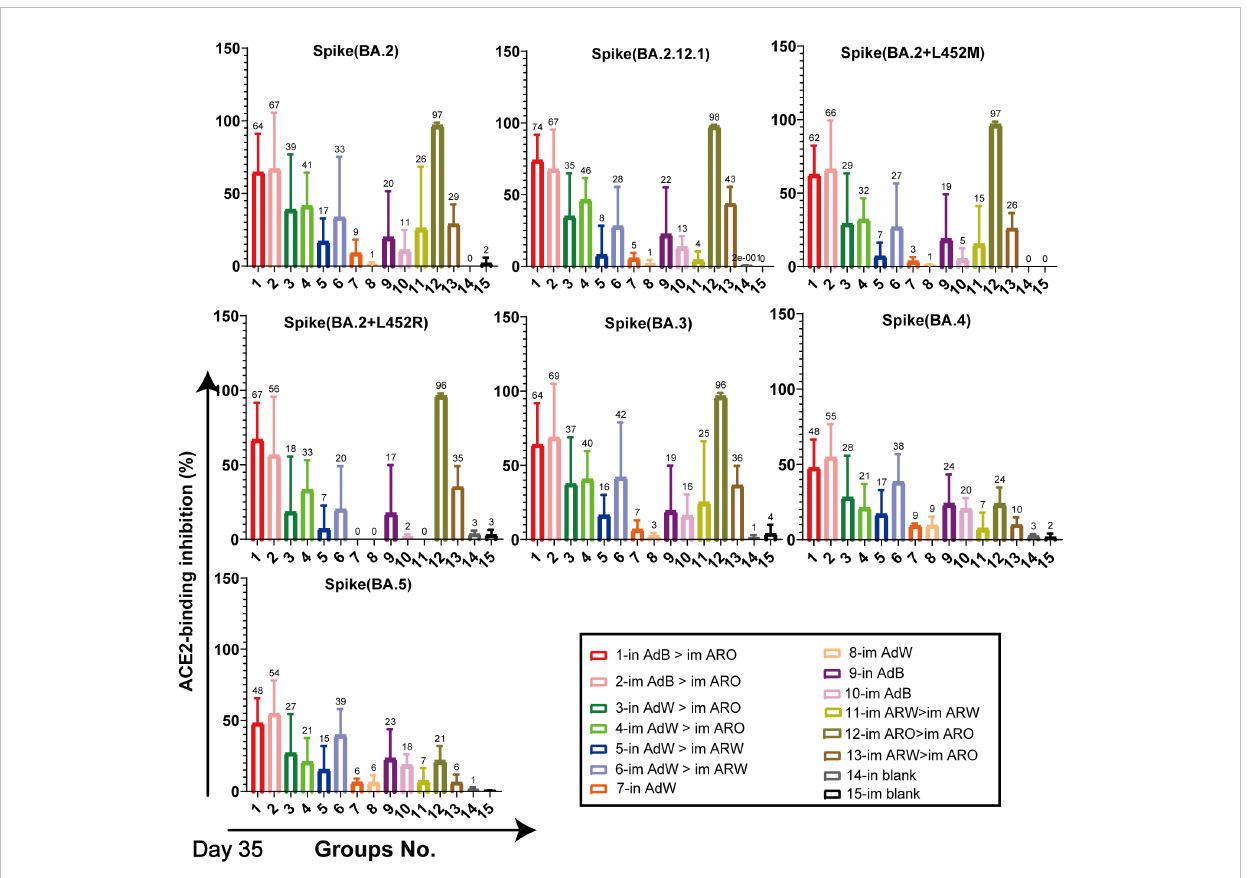
FIGURE 7 Neutralisation capacity of sera was observed by measuring the inhibition of binding between ACE2 and SARS-CoV-2 spike proteins on day 35 after primary immunisation. Spike proteins were from BA.2, BA.2.12.1, BA.2+L452M, BA.2+L452R, BA.3, BA.4, and BA.5 strains, respectively. Negative ACE2-binding inhibition rates are shown as zero (n = 5 per group). Bars represent the mean ± SD; numbers represent the mean of the corresponding